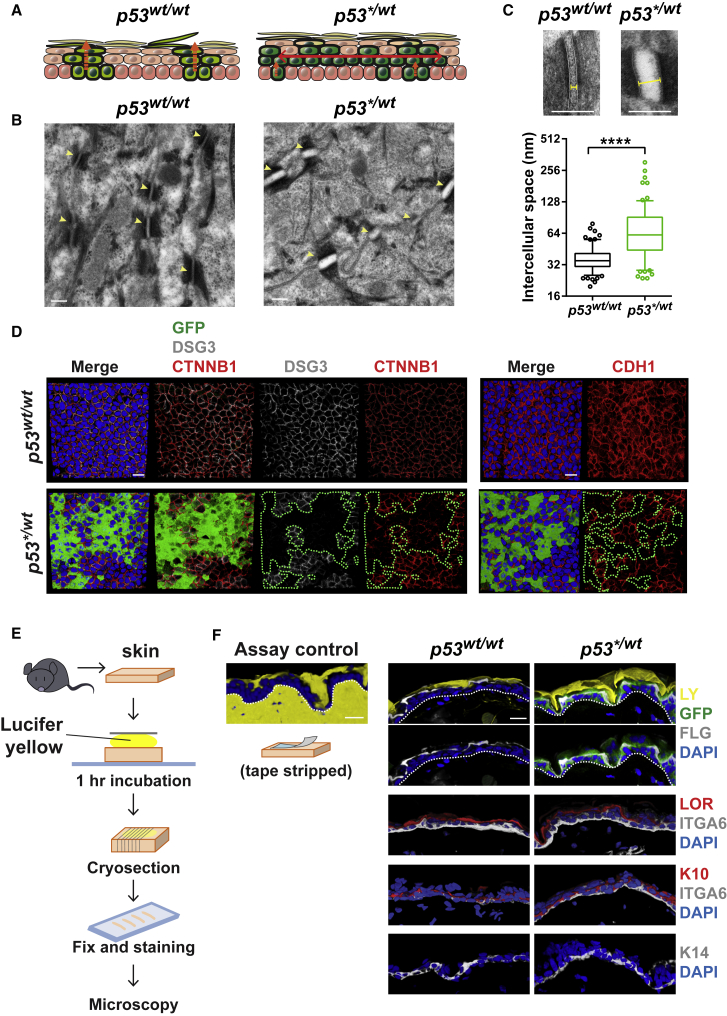
Disrupted Cell Adhesion in p53∗/wt Epidermis at 1 Year post Induction(A) Schematic: movement of differentiating cells is predominantly vertical in p53wt/wt mice but the excess of suprabasal over basal cells in p53∗/wt IFE argues there is extensive lateral displacement of mutant cells.(B–F) Analysis of epidermis colonized by p53∗/wt at 1 year post induction. Uninduced mice were used as control. n = 3 mice per group.(B) Transmission electron microscopy of induced p53∗/wt and uninduced p53wt/wt IFE. Arrows indicate desmosomes. Scale bar, 200 nm.(C) Intercellular distance (yellow capped bar) at desmosomes in p53wt/wt (black) and p53∗/wt (green) IFE. Box plots show median (line across box), 25th and 75th percentiles (box) and 5th and 95th percentiles (whiskers), dots are outliers (dots). n = 150 desmosomes from 3 animals per group. Scale bar, 200 nm. ∗∗∗∗p < 0.0001 by Mann-Whitney test.(D) Bottom-up view of rendered confocal z stacks showing the expression of cell adhesion molecules in p53∗/wt and p53wt/wt IFE. Images are representative from 3 mice per genotype. White, DSG3; red, CTNNB1 (left panels), CDH1 (right panels); green, GFP; blue, DAPI. Green line, p53∗/wt clone area. Scale bar, 20 μm.(E) Scheme of epidermal permeability barrier function assay.(F) Cryosections of p53∗/wt epidermis showing normal expression of markers and barrier function compared to that of p53wt/wt. p53∗/wt colonized over 70% at this time point and GFP (green) indicates the expression of p53∗ transcript. Lucifer yellow is excluded by a normal competent epidermal surface barrier; in the assay control, barrier was removed by tape stripping. Yellow, lucifer yellow; blue, DAPI. FLG, filaggrin; LOR, loricrin; ITGA6, integrin α6; K10, keratin 10; K14, keratin 14. Scale bar, 20 μm.See also Table S7.